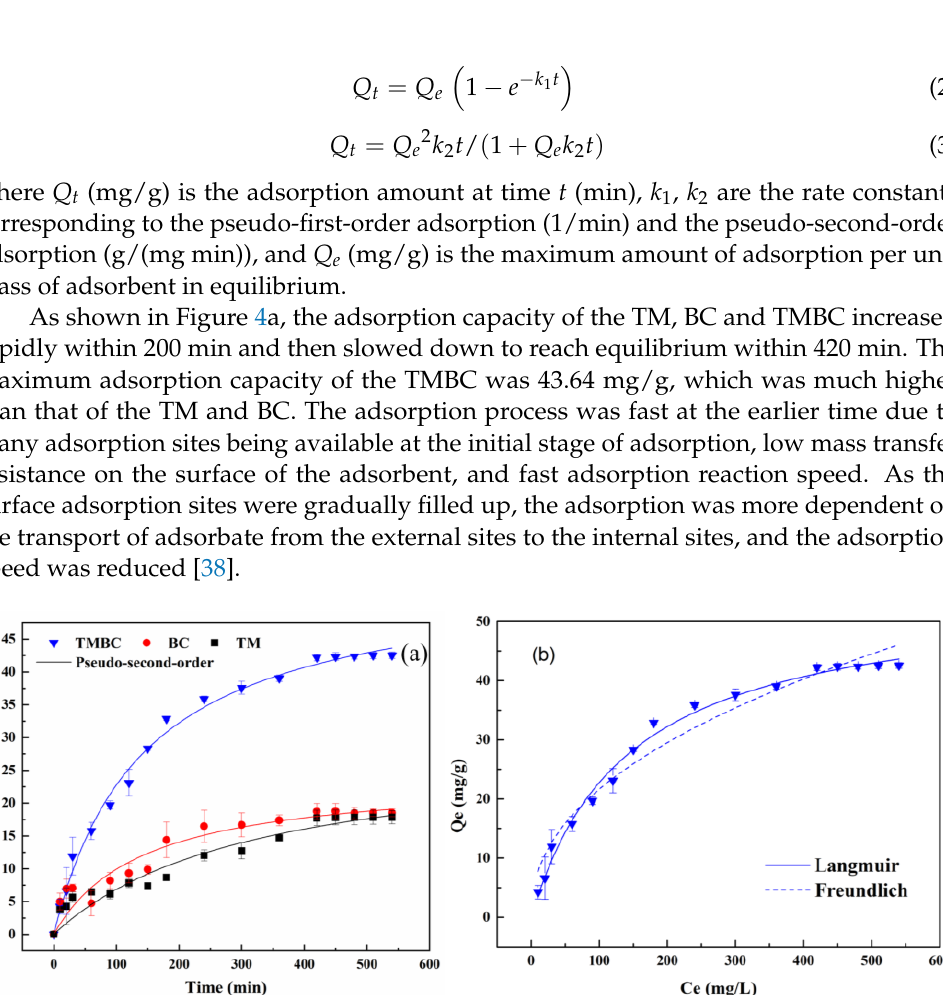
Figure 4. ( a ) Adsorption kinetics of Cr (VI) by TM, BC, TMBC and ( b ) adsorption isotherms of